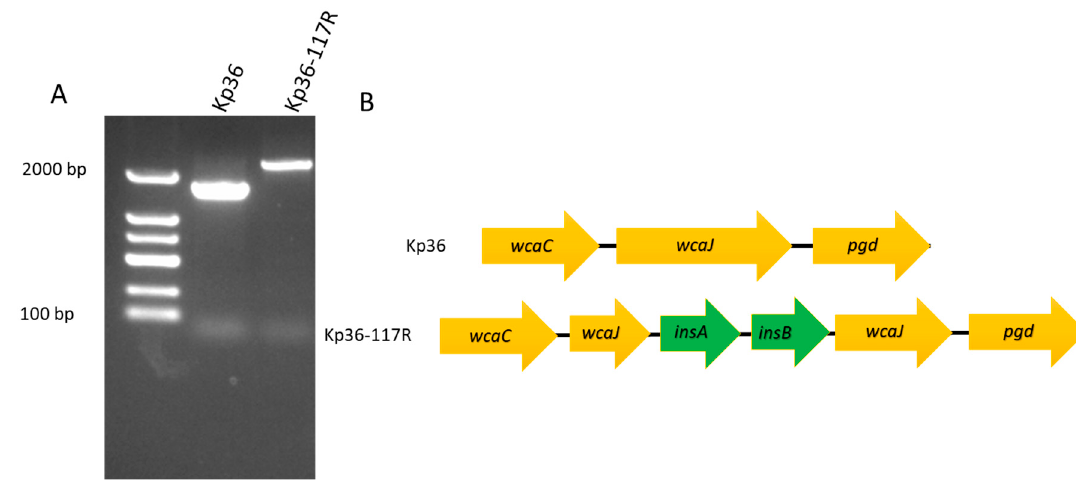
Figure 3. ( A ) Agarose gel electrophoresis of PCR products to verify the insertion of mobile genetic elements ( insA and insB ) in the phage resistant mutant Kp36-117R. Both PCR products, including wild-type strain Kp36, were confirmed by sequencing. ( B ) Schematic representation of wcaJ in K. pneumoniae Kp36 and Kp36-117R. Genes are represented as arrows.